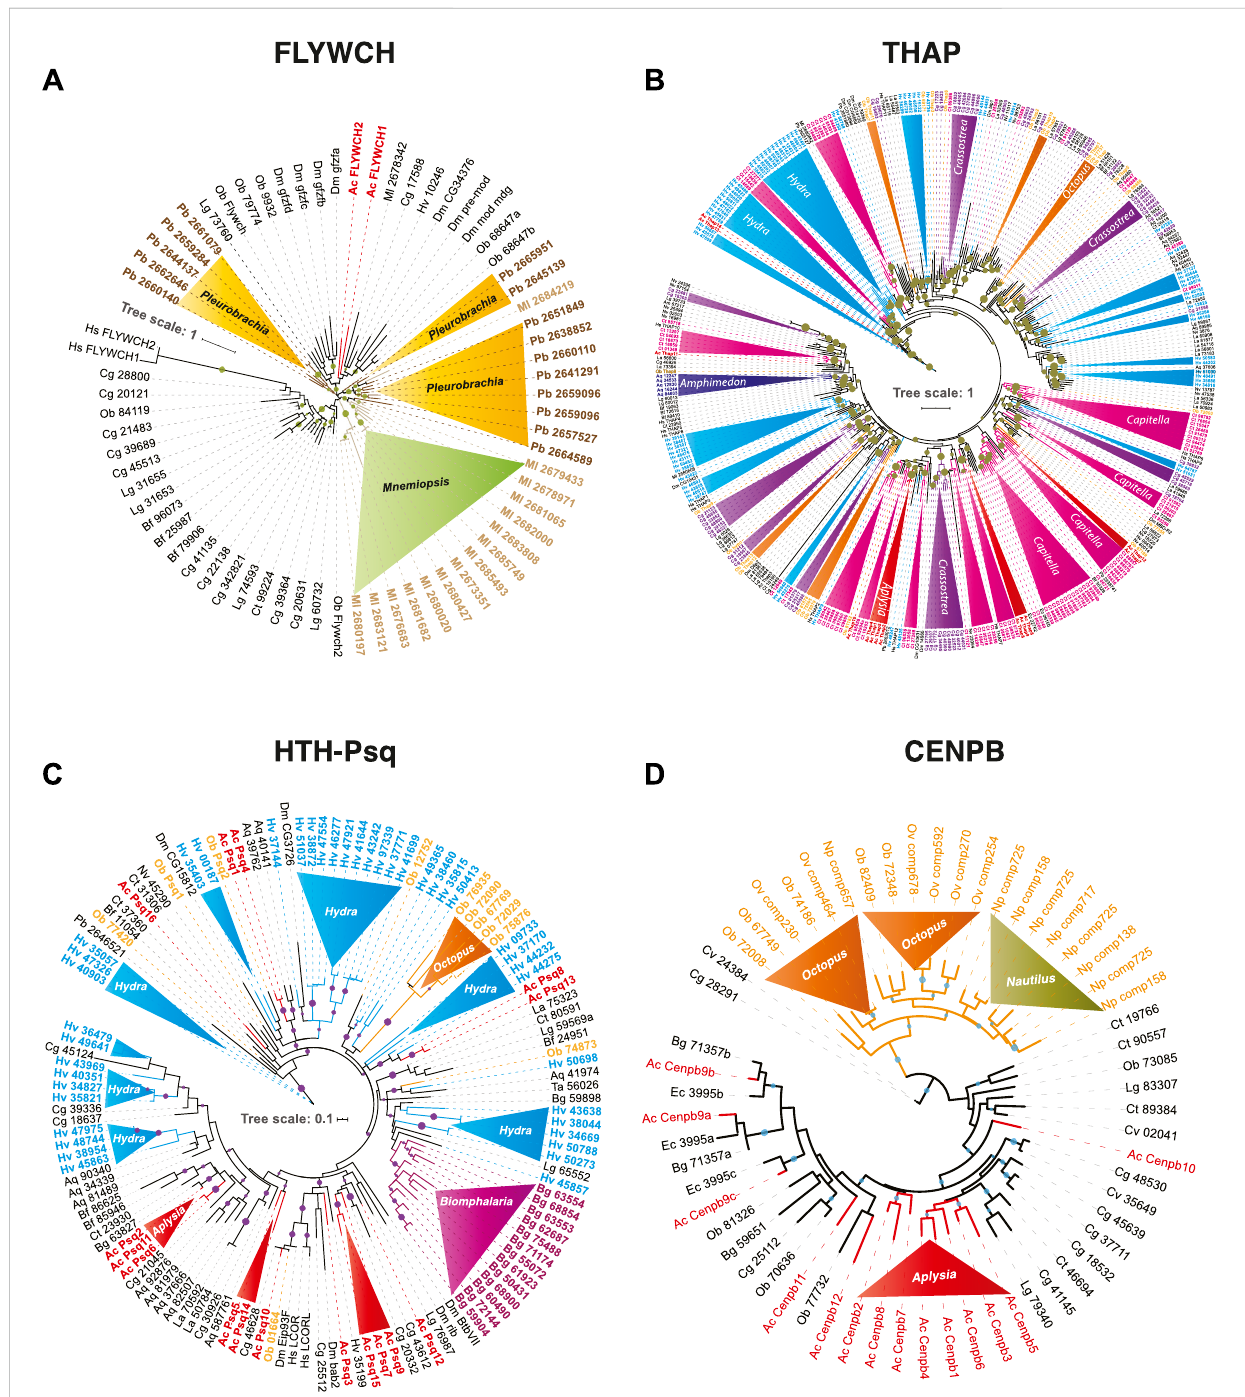
FIGURE 2 Independent expansion and convergent evolution of transposon-derived transcription factors in Metazoa. The phylogenetic tree represents the independentexpansionandevolutionoftransposon-derivedtranscriptionfactorsproteinfamiliesacrossmetazoans.Eachsolid-colortrianglerepresents species-speci fi c expansion that has no homologs in related species. We used the following DNA binding domains – FLYWCH (A) , THAP (B) , HTH-Psq (C) , and CENPB (D) — as illustrative examples to build the maximum likelihood (ML) tree. The trees show independent FLYWCH gene expansion in the ctenophores Mnemiopsis and Pleurobrachia (A) . Similarly, independent THAP genes expansion in Capitella , Octopus , Crassostrea , Hydra (B) , HTH-Psq expansion in Hydra , Biomphalaria , Aplysia, and Octopus (C) , and Independent convergent domestication of CENPB genes in Octopus , Nautilus, and Aplysia (A) . High-resolution images of each of these trees are presented in Supplementary Figures.S1 –